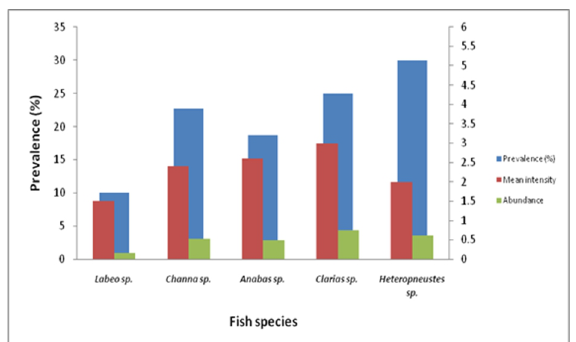
Figure 4. Variation of abundance, prevalence and mean intensity of monogenean parasite ( Gyrodactylus sp.) harbouring different fish host